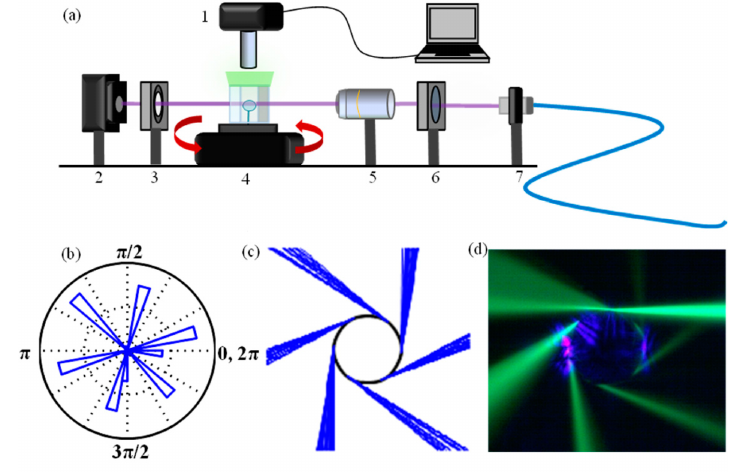
Figure 1. Experimental set-up for visualizing the directional emission of an asymmetric resonant cavity (ARC) in aqueous solution. ( a ) Setup components: 1. imaging system; 2. photodetector; 3. spatial filter; 4. rotation stage, with ARC and the chamber with GFP in PBS buffer; 5. 10 × objective; 6. quarter-wave plate for polarization control; 7. fiber collimator; ( b ) Polar histogram of refractive escape for six-pole boundary ARC; ( c ) Ray-tracing simulation; ( d ) Real color image of directional emission by GFP fluorescence imaging of an ARC with a 63- µ m diameter. Reprinted with permission from